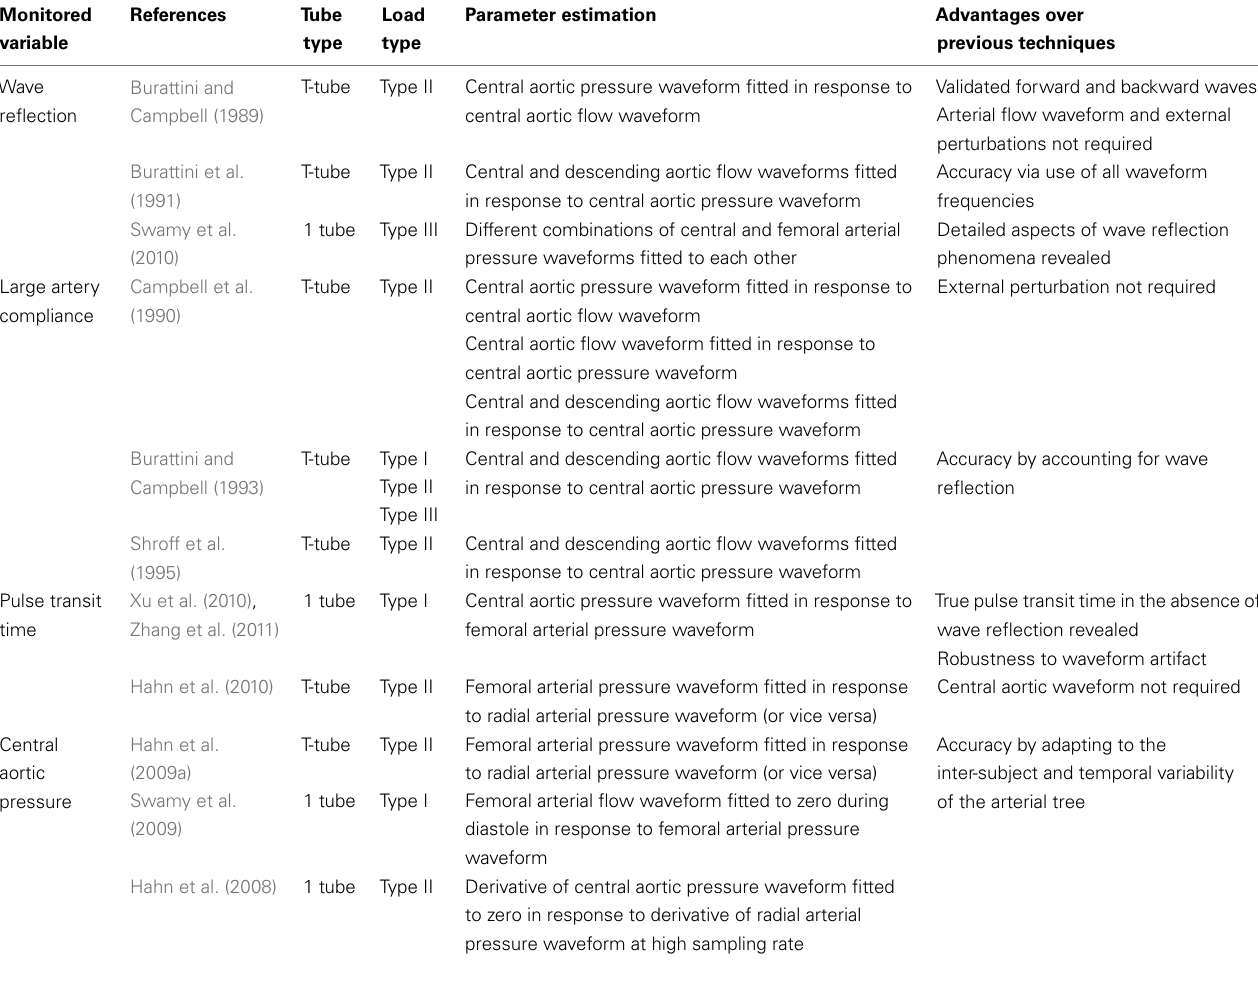
Table 1 | Summary of available tube-load model parameter estimation techniques for monitoring arterial